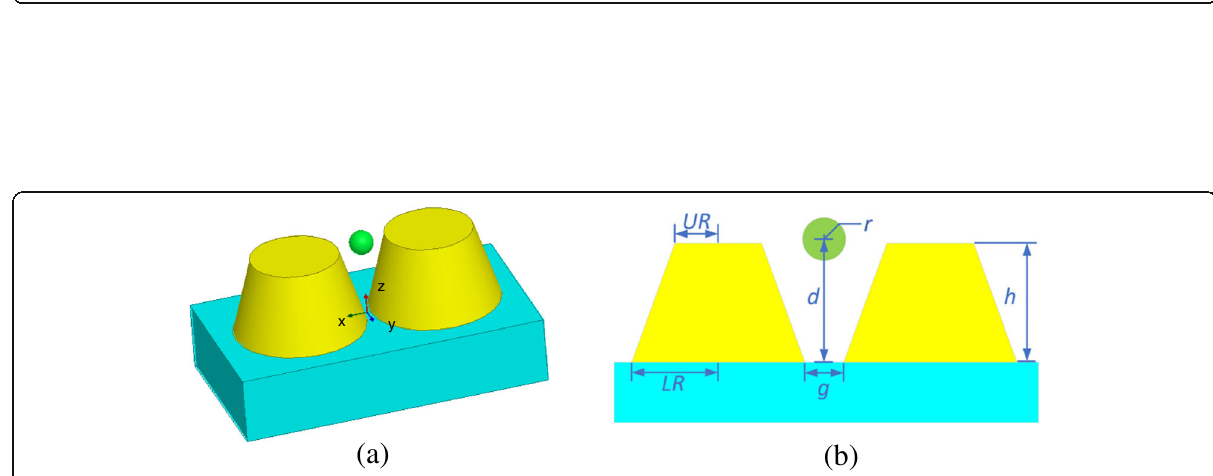
Fig. 8 The optical forces and optical potentials exerted on the nanosphere in the system of gold nanosphere dimer, when the nanosphere moves from (0, 0, − 30 nm) to (0, 0, − 17 nm). a The optical forces. b The optical potentials